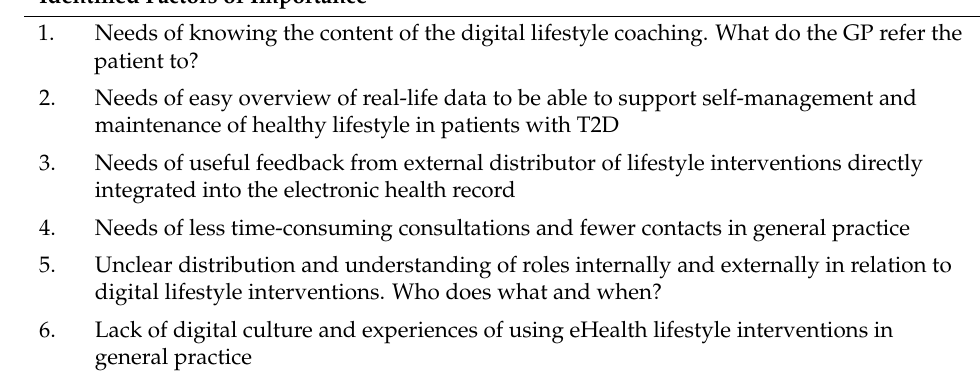
Table 4. Identified factors of importance affecting use of digital individualised coaching of Type 2 diabetes in a general practice